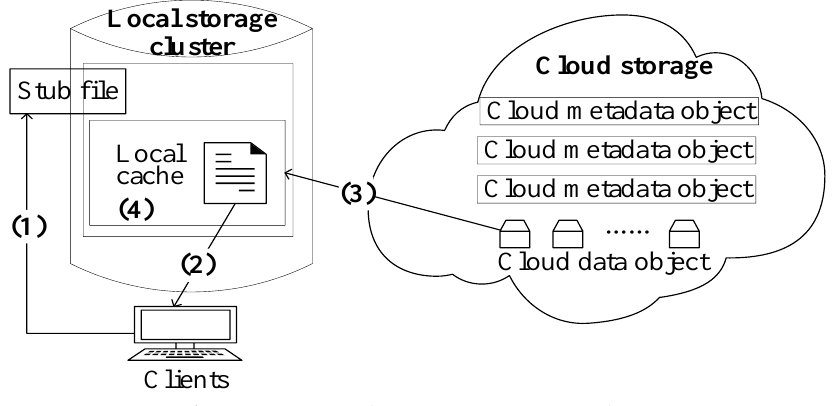
Figure 5. Diagram of data read operation workflow.